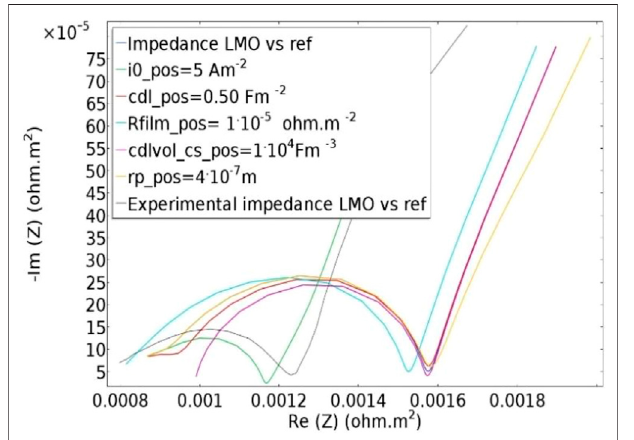
FIGURE10| Stateofdischarge (SOD)characteristics atvariousc-rates.